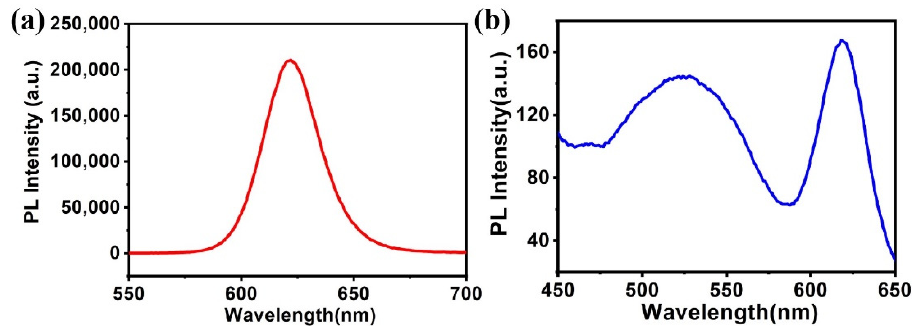
Figure 10. PL of CdSe/ZnS QDs ( a ) and QDs/polymer/GO fluorescence nanohybrid ( b ).